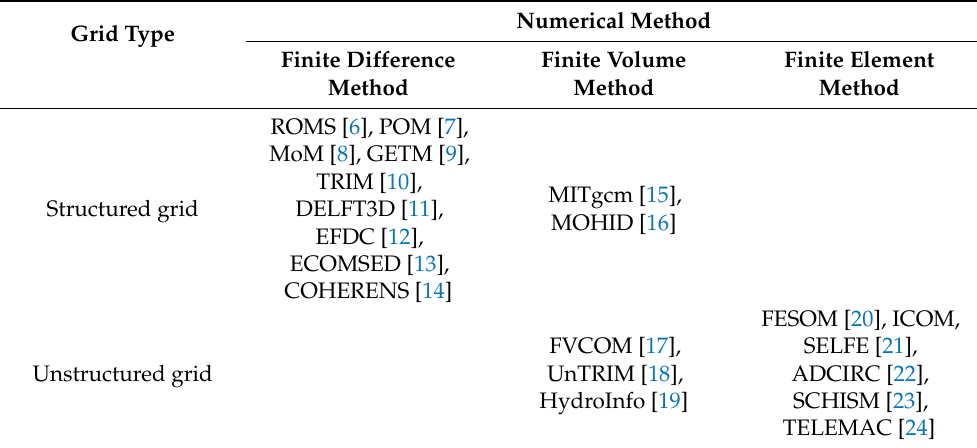
Table 1. Categorization of the commonly used hydrodynamic